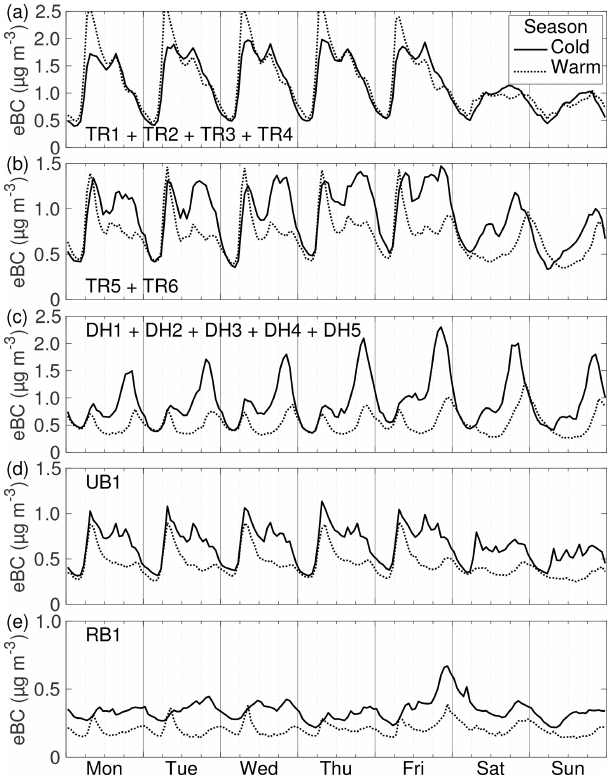
Figure 6. Diurnal variation in eBC for different station categories: (a) traffic sites that were not influenced by wood burning (TR1– 4), (b) traffic sites that were influenced by wood burning (TR5–6), (c) detached housing sites (DH1–5), (d) urban background (UB1), and (e) regional background (RB1). The diurnal variation is deter- mined separately for the cold (from November to March) and warm (from May to September)